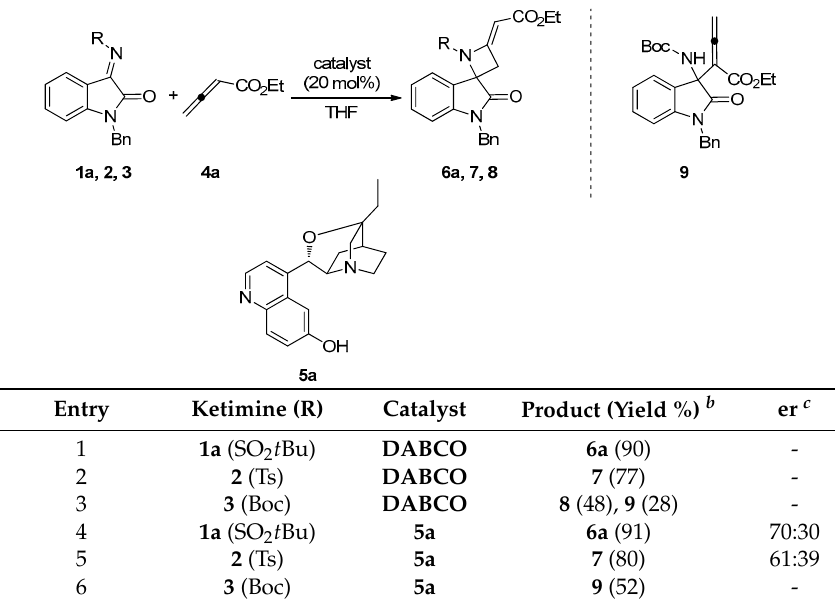
Table 1. Variation of the isatin-derived ketimines. a